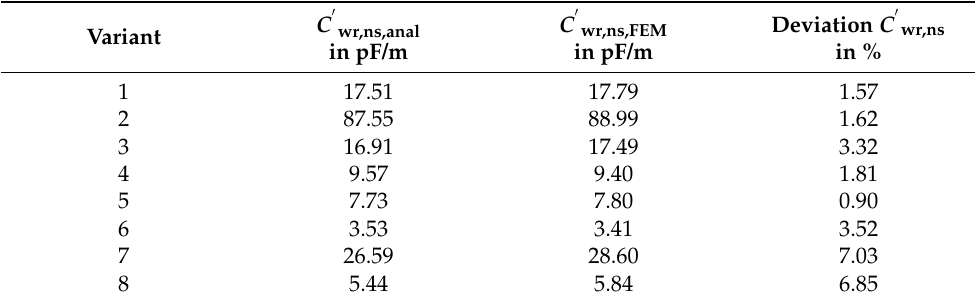
Table 5. Comparison of the end-winding portions of the winding-to-rotor capacitance calculated analytically with the FEM